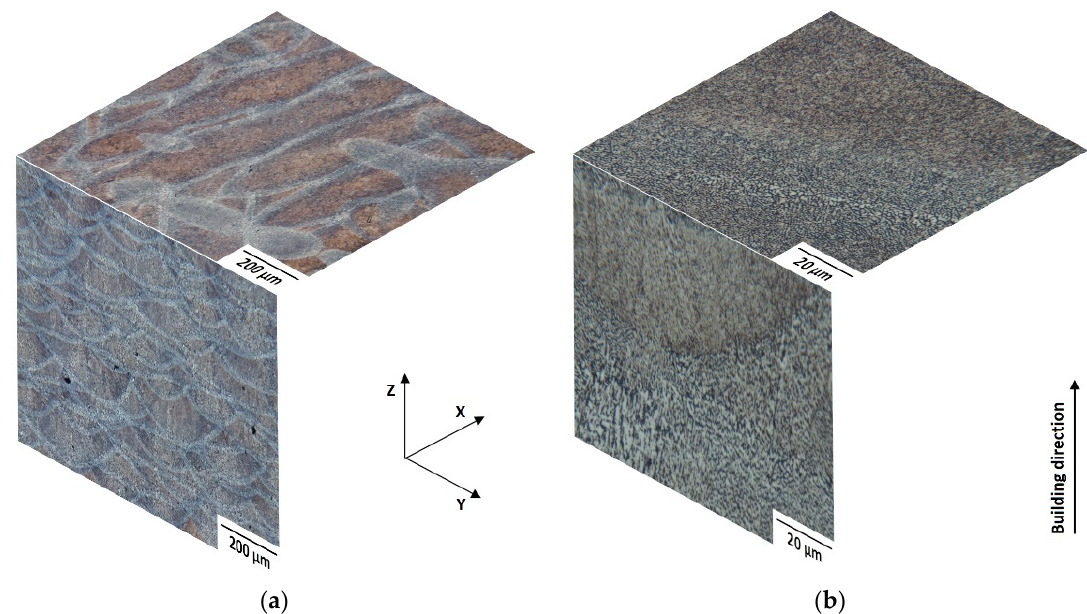
Figure 3. Typical microstructure of the AlSi7Mg Z-built parts produced by SLM on the hot platform at 200 °C; ( a ) 100× and ( b ) 1000× magnifications.